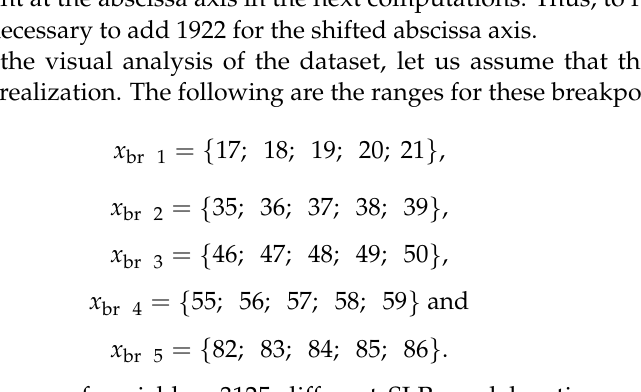
Figure 7. Data on quantity of earthquakes of magnitude 7 or higher by year.